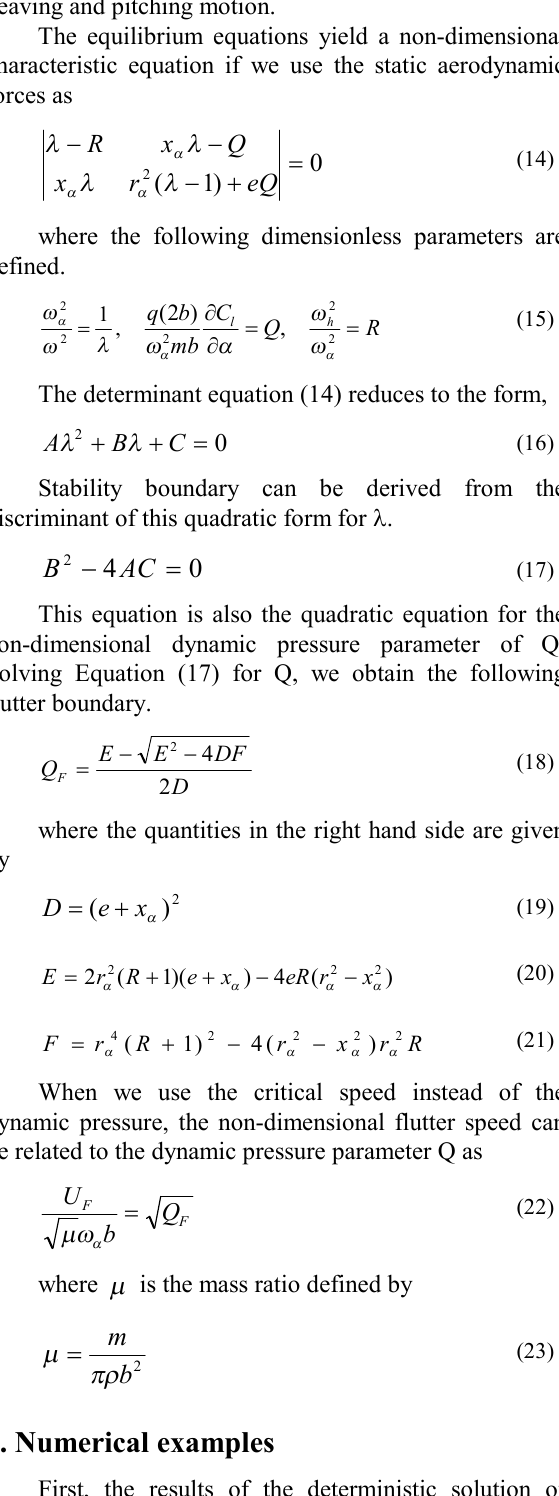
Figure 3. The scattering dots are the results of calculation of ten times in each frequency ratio with the step of 0.01. As can be seen in the figure, the boundary has higher sensitivity for the lower frequency ratio. The deviation in the location of the center of gravity does not have much effect when the frequency ratio is above